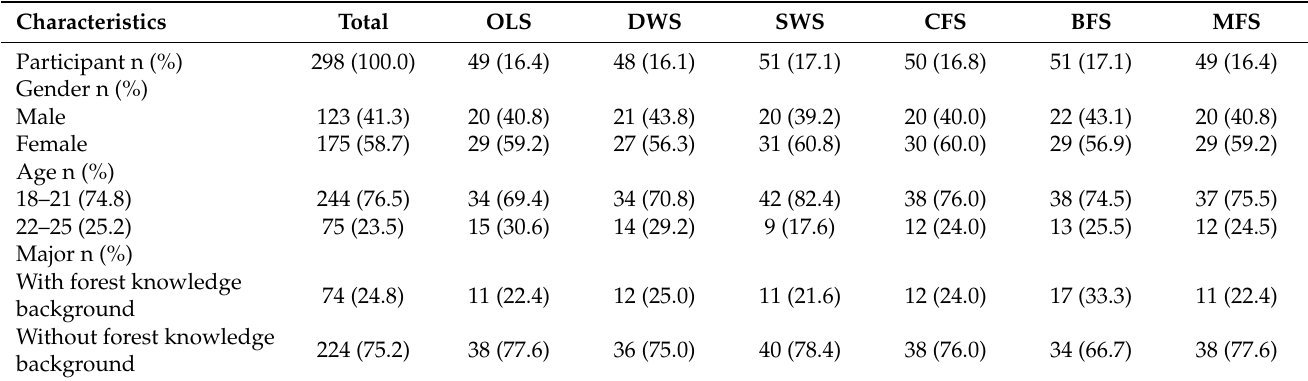
Table 2. Main socio-demographic characteristics of the sample of